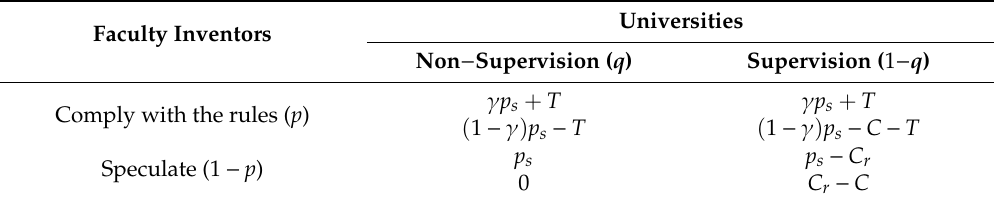
Table 2. Variables in the game